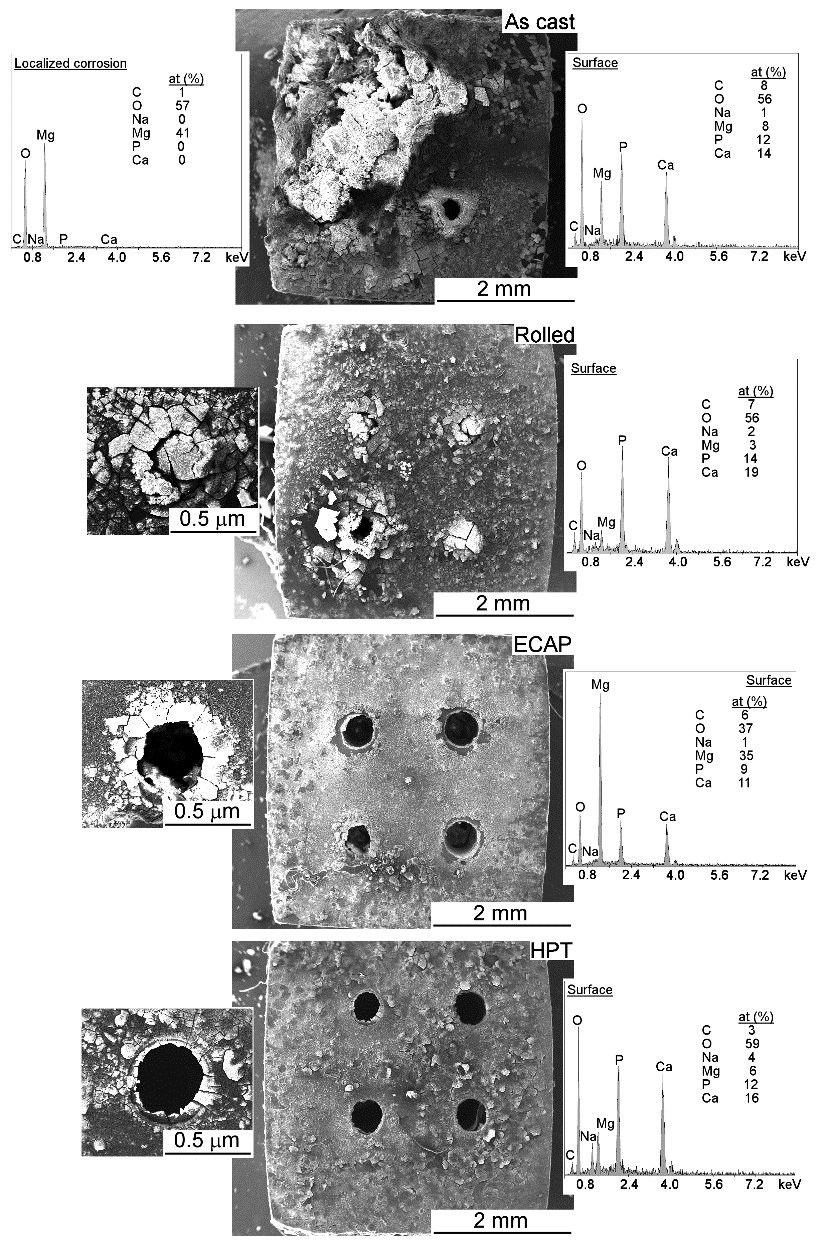
Figure 6. Appearance of scaffolds fabricated from pure magnesium in the as-cast condition and after processing by rolling, ECAP, and HPT. EDS analysis of composition of the surface of the corroded scaffolds are also presented.